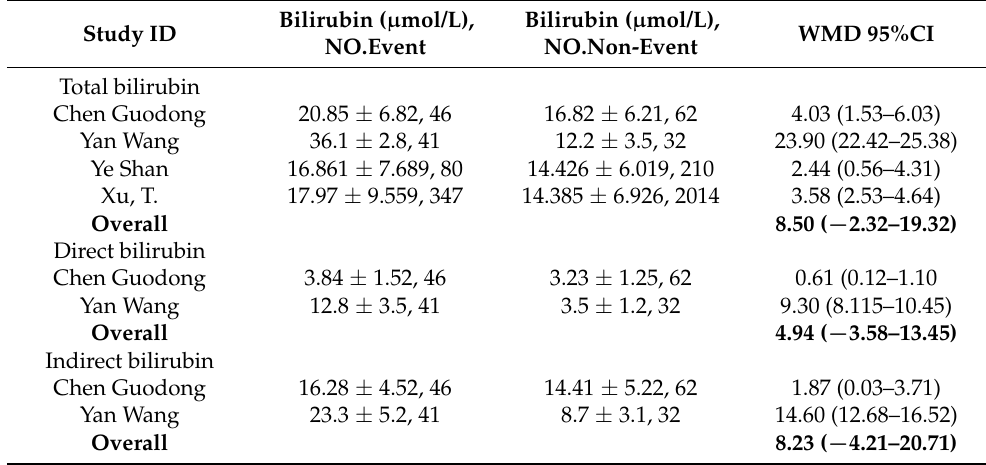
Table 3. The weighted mean difference (WMD) with 95% confidence interval (CI) for the circulating levels of bilirubin between the different groups.